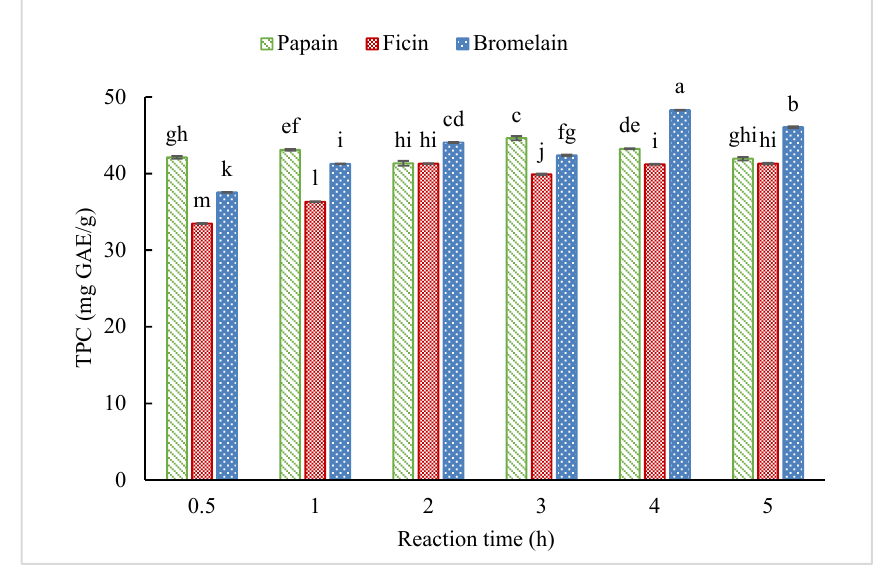
Figure 3. Total phenolic content (TPC) of CGM hydrolysates at 1 mg/mL under different reaction times prepared by papain, ficin, and bromelain. (Different letters indicate significant differences at p < 0.05 for each enzyme).